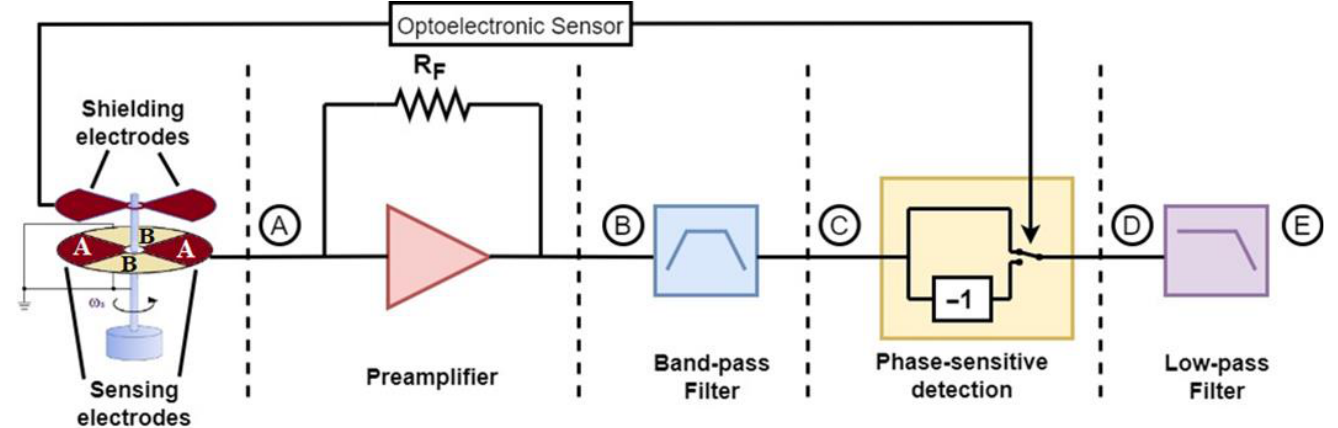
Figure 1. Block diagram of the field mill sensor readout system.